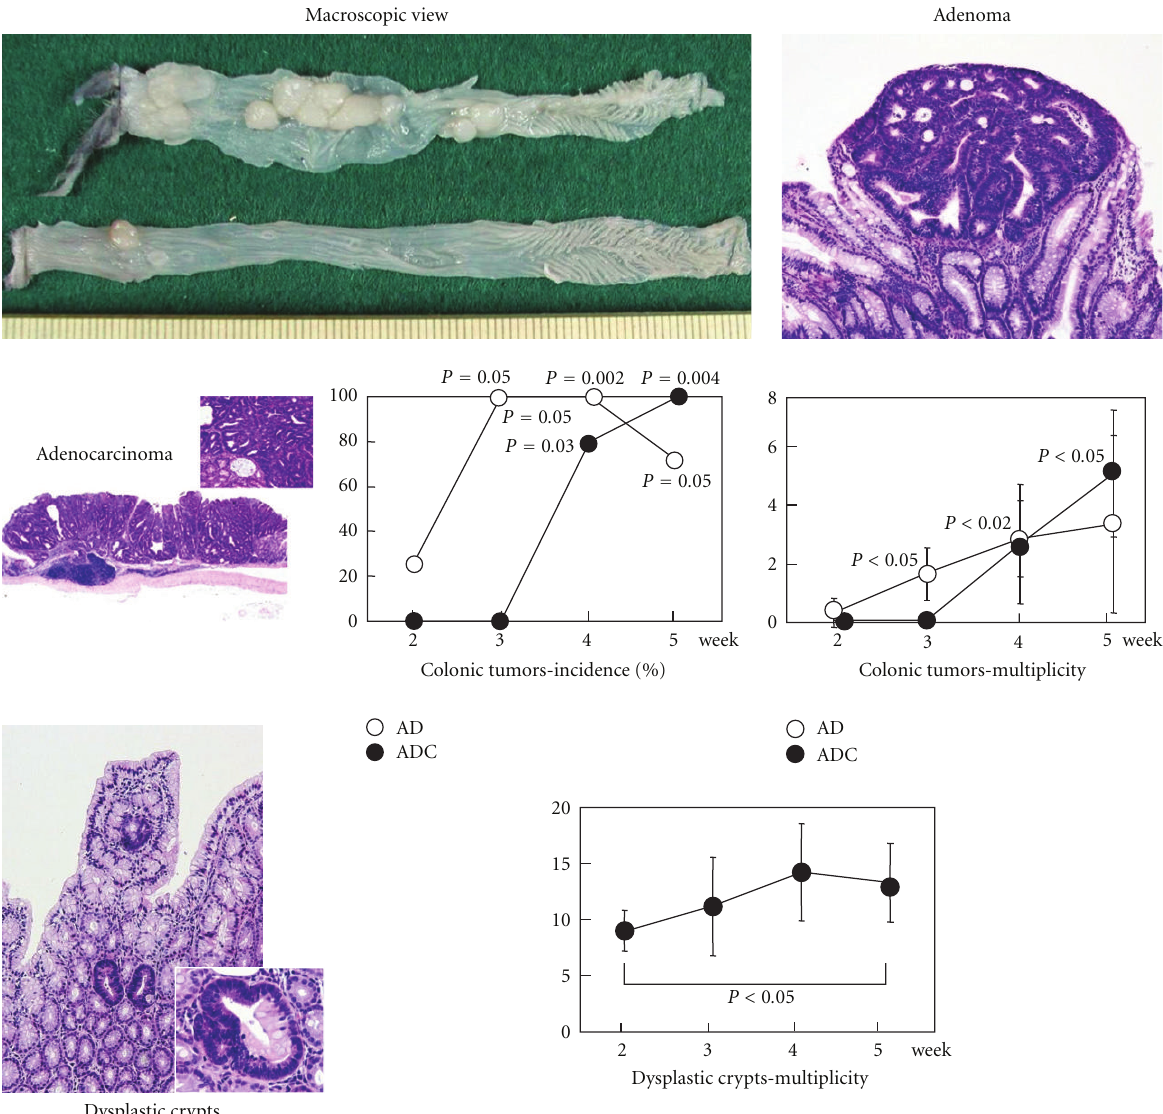
Figure 18: Macroscopic view and histopathology of colonic tumors and dysplastic crypts in APC Min/ + mice that received 2% DSS for one week. Graphs show developments of these lesions during the study (up to 5